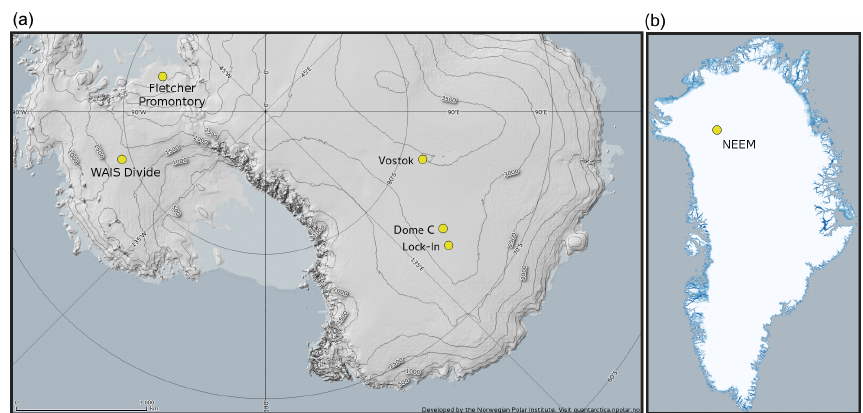
Figure 1. (a) Map of Antarctica with the sites of Lock-In, Dome C, Vostok, WAIS Divide, and Fletcher Promontory shown (made with the Quantartica package). (b) Map of Greenland with the site of NEEM shown (using Greenland Ice Mapping Project data; Howat et al., 2014). Table 1. Summary of the different ice core sections studied in the paper with their associated atmospheric references. Ice core section Coordinates Accumulation Atmospheric reference (centimeters ice equivalent per year) Modern Lock-In 74 ◦ 08 (cid:48) S, 126 ◦ 10 (cid:48) E 3.9 a WAIS Divide discrete b Modern Dome C 75 ◦ 06 (cid:48) S, 123 ◦ 20 (cid:48) E 2.7 c WAIS Divide discrete b Holocene Dome C Same as above 3 . 1 ± 0 . 15 d Fletcher–EDC composite e DO6-9 Dome C Same as above 1 . 5 ± 0 . 15 d WAIS Divide CFA f D021 Vostok 78 ◦ 28 (cid:48) S, 106 ◦ 50 (cid:48) E 1 . 5 ± 0 . 05 d Deconvoluted NEEM CFA